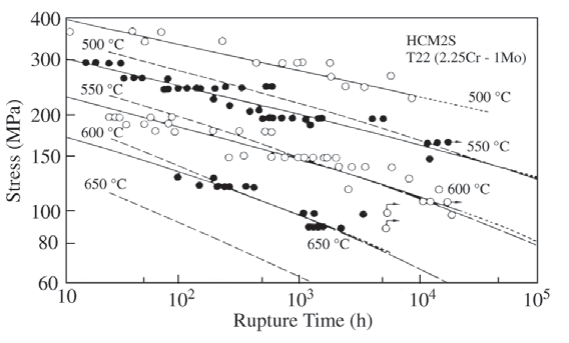
Figure 1. Creep Properties of T22 and T23 (after Ref.